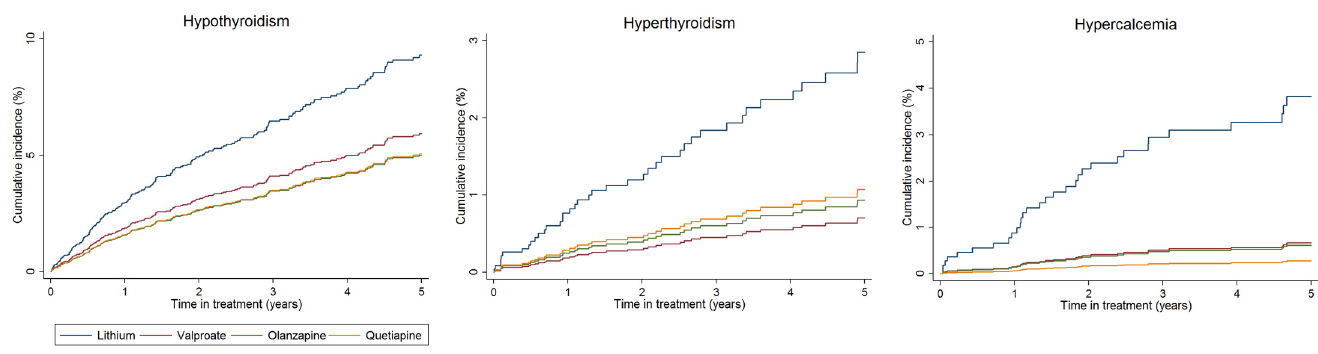
Fig 2. Cumulative incidence estimates of adverse endocrine event rates. From PS and age adjusted competing-risks regression. Note differences in scale of y -axis for each plot.